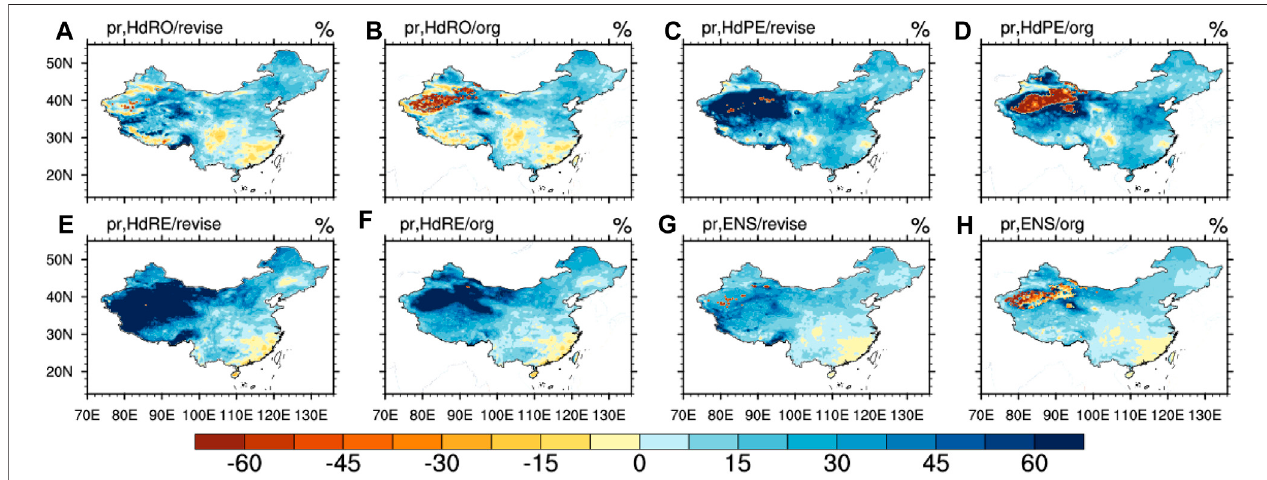
FIGURE 10 | Change rates of precipitation in the late 21st century compared with the historical period before (B,D,F,H) and after correction (A,C,E,G) .